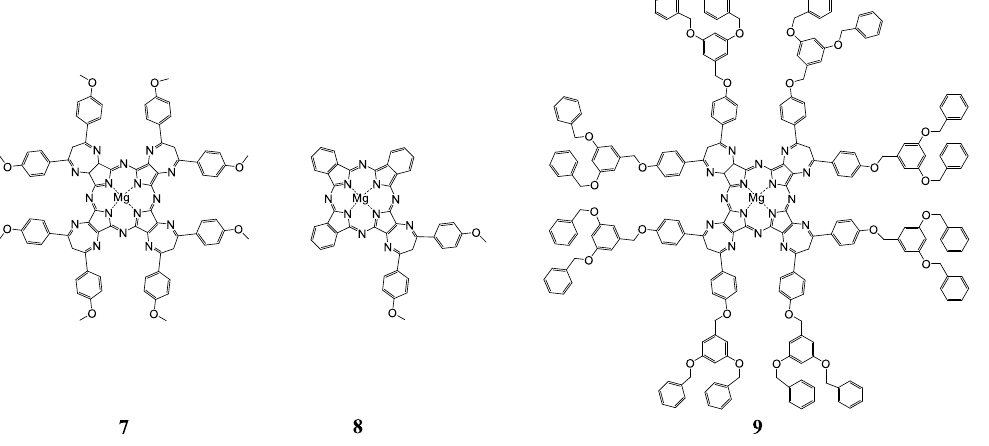
Figure 14. Chemical structures of Mg-porphyrazines.